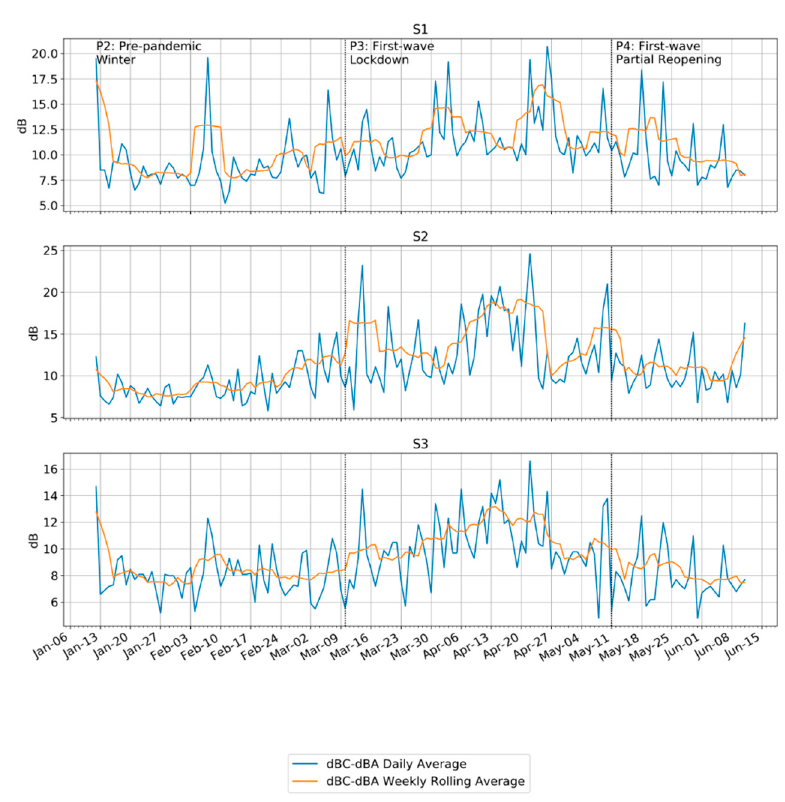
Figure 6. Comparison of background (L 90 ) and emergent (L 10 ) statistical indicators throughout the lockdown period (P3). Emergent sounds declined more than background sounds during P3; data from P2 and P4 are shown for context.